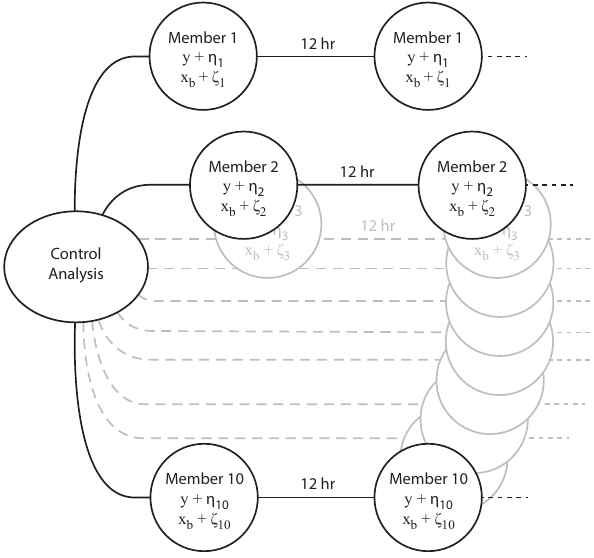
Figure 2. Schematic diagram of the XB-EDA